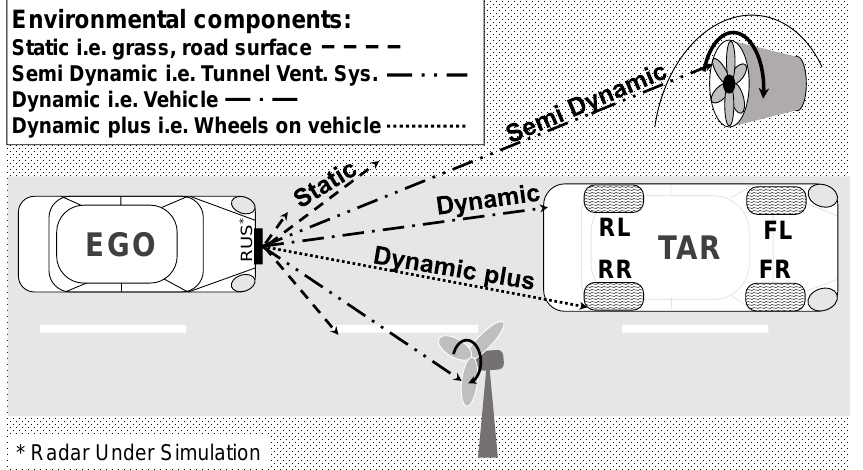
Figure 3. Environment classes for the sensor